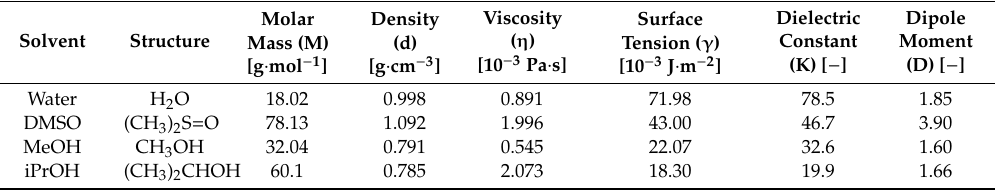
Table 1. Selected physicochemical parameters of water, DMSO, methanol and isopropanol at 20 ◦ C